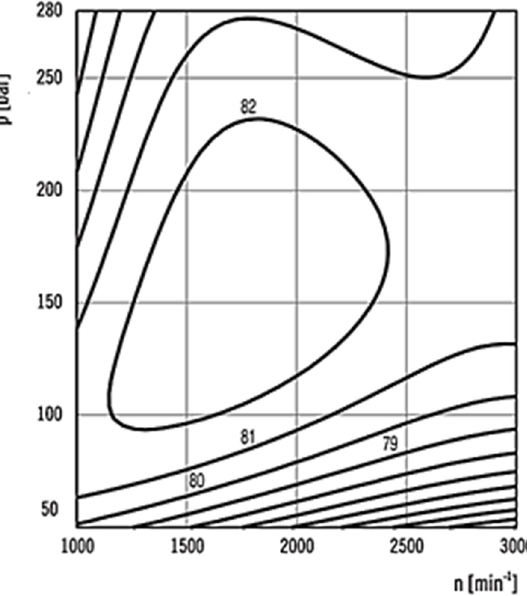
Figure 8. Total efficiency of hydraulic pump/motor function of pressure and rotational speed con- dition.